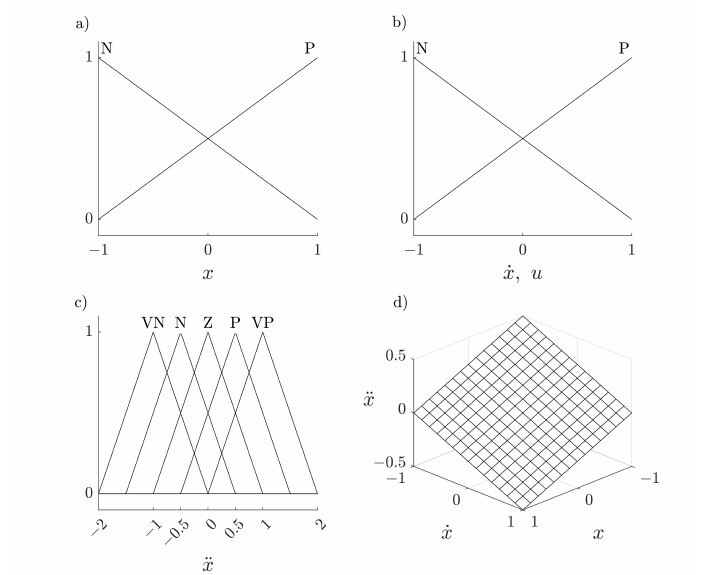
Figure 10. Fuzzy sets; ( a ) input set x , ( b ) input set ˙ x , u , ( c ) output set ¨ x centre of gravity and ( d ) output surface between ¨ x , ˙ x and x .